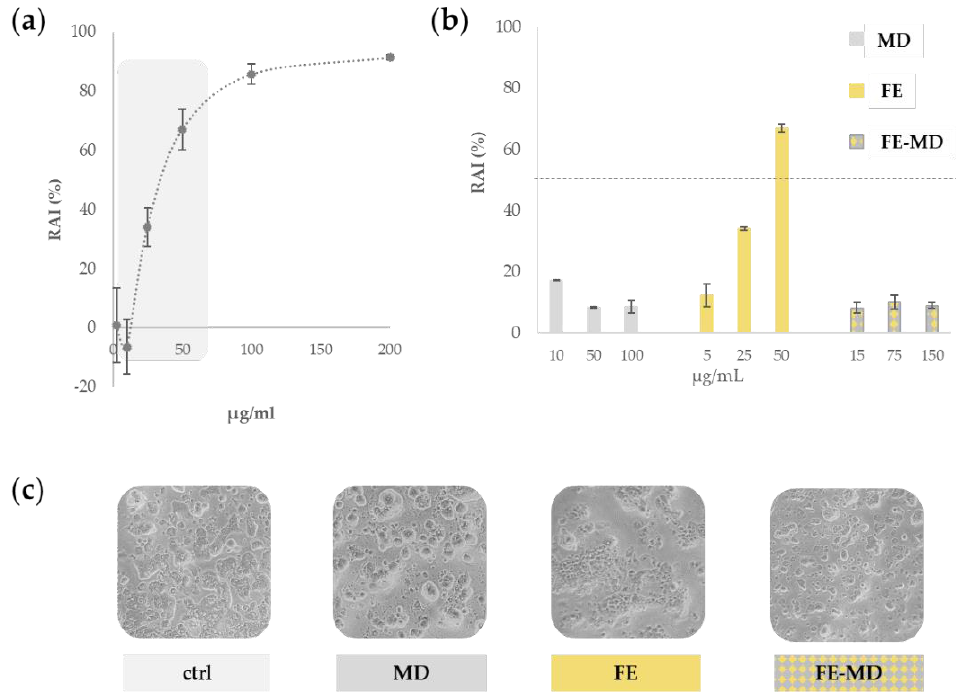
Figure 3. ( a ) Preliminary assessment of redox activity inhibition (RAI %) of floret extract (FE) towards Caco-2 cells. ( b ) Comparison of RAI % due to FE, FE-MD formulation, and MD. ( c ) Representative images of untreated Caco-2 cell line, and cells treated with maltodextrin (MD), floret extract (FE), and FE-MD at the highest dose. Images were acquired with an Inverted Phase Contrast Brightfield Zeiss Primo Vert Microscope.